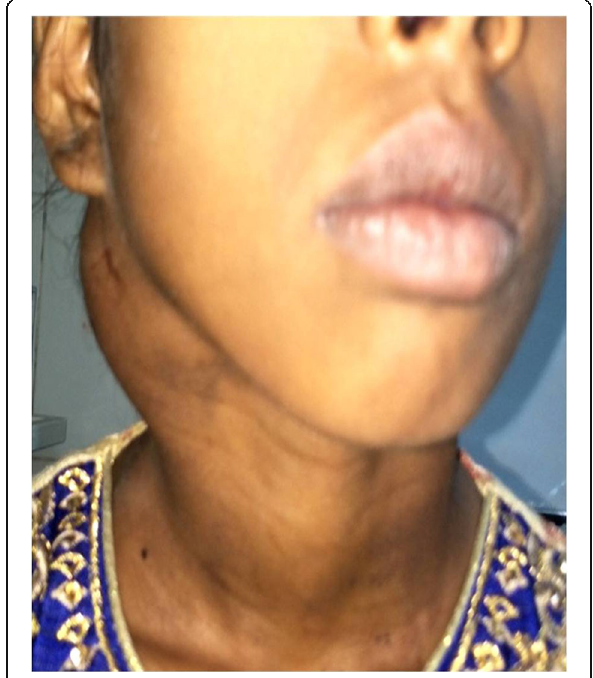
Fig. 1 A female child with nasopharyngeal carcinoma presenting with right side neck